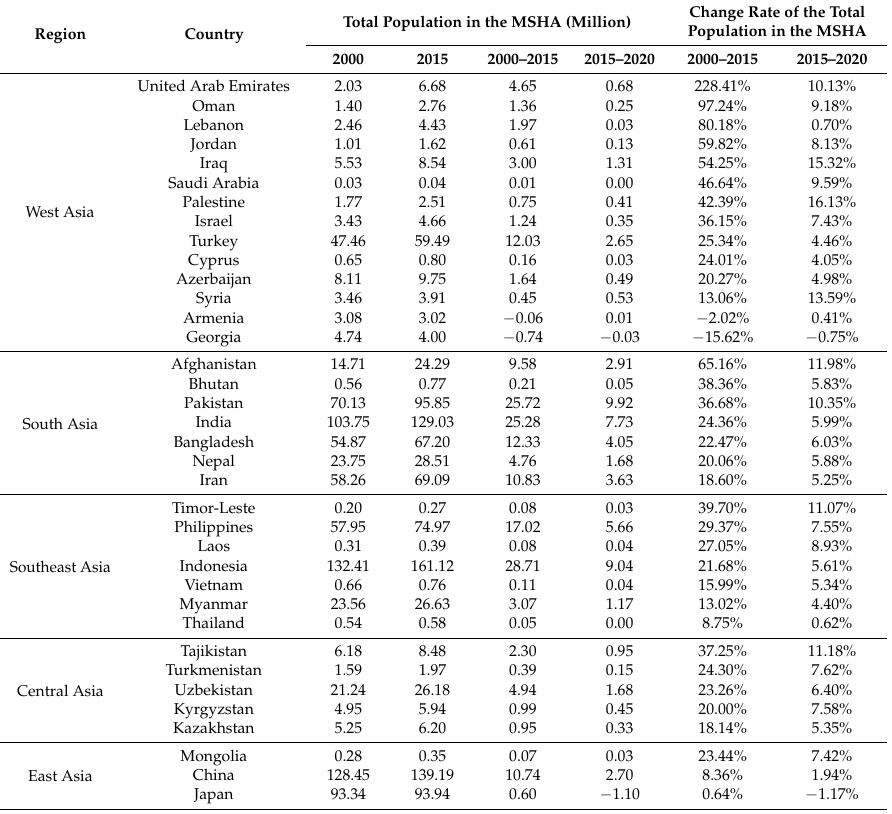
Table A2. Changes in the total population living among different MSHA from 2000 to 2020 in each country.